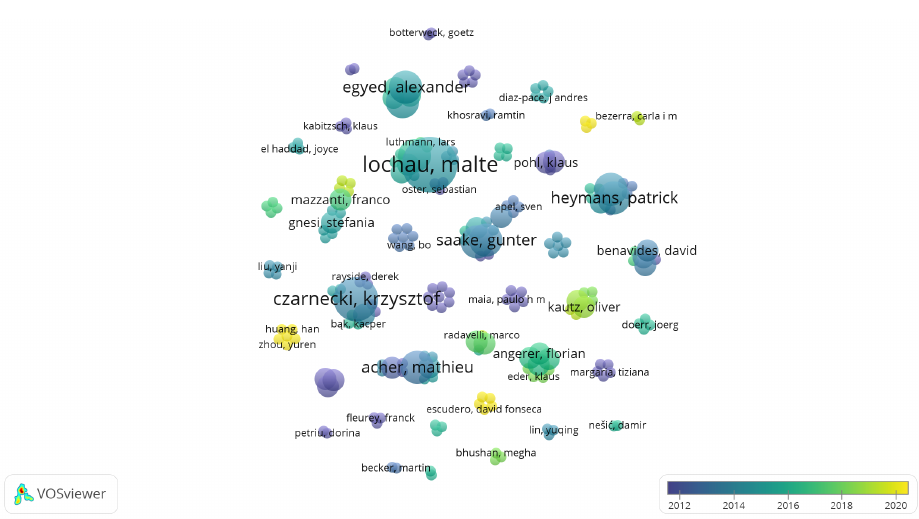
Figure 25. Relationships between the most relevant authors and their